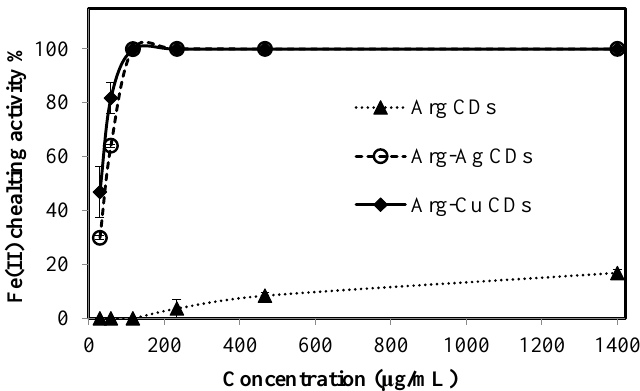
Figure 8. Fe(II) chelating activity % of Arg CDs, Arg-Ag CDs, and Arg-Cu CDs.